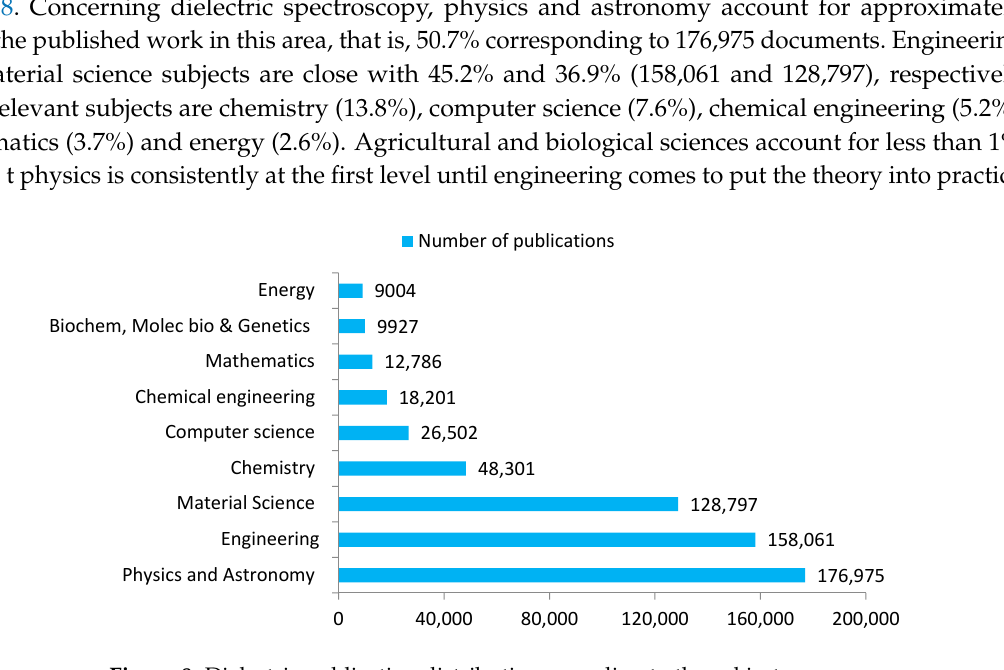
Figure 8. Dielectric publication distribution according to the subject